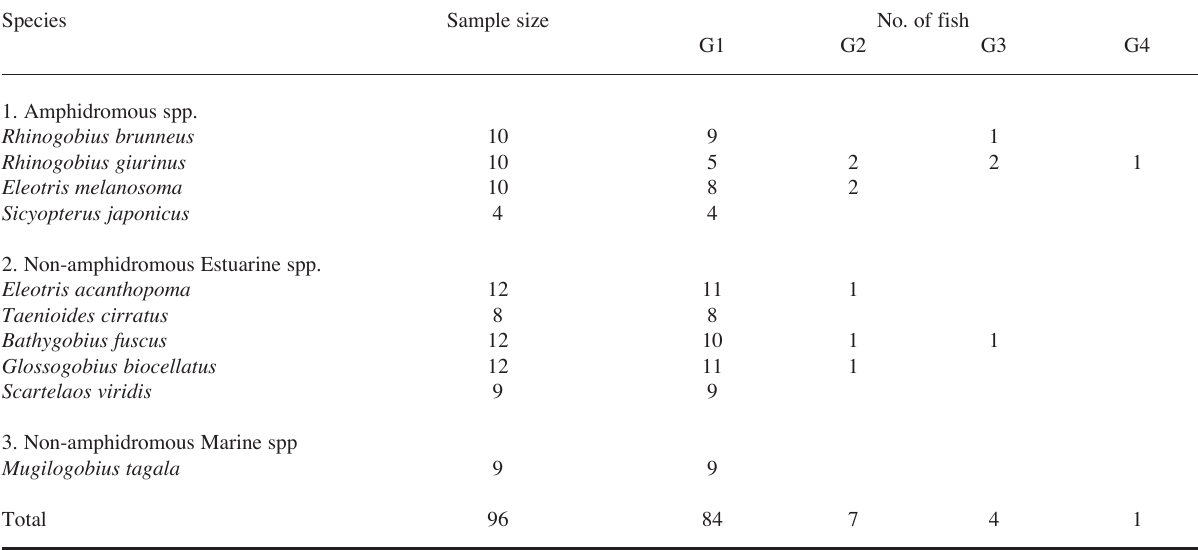
T ABLE 4. – The species composition of gobies in each of the PCA groups in Figure 4 classified by otolith elemental composition. Species Sample size No. of fish G1 G2 G3 G4 1. Amphidromous spp.